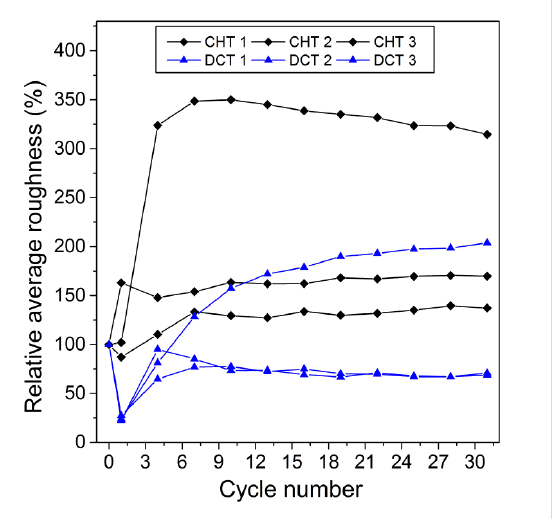
Figure 6: Evolution of the relative average roughness after each test